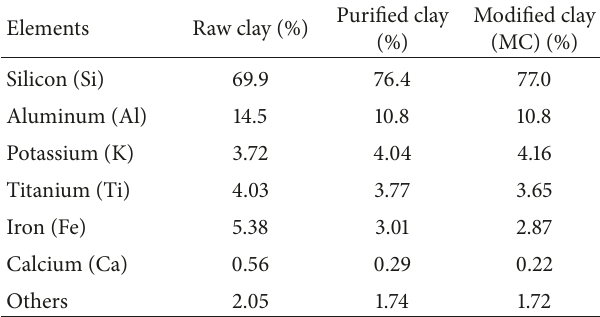
Table 2: Elemental analysis of raw clay, purified clay, and modified clay.